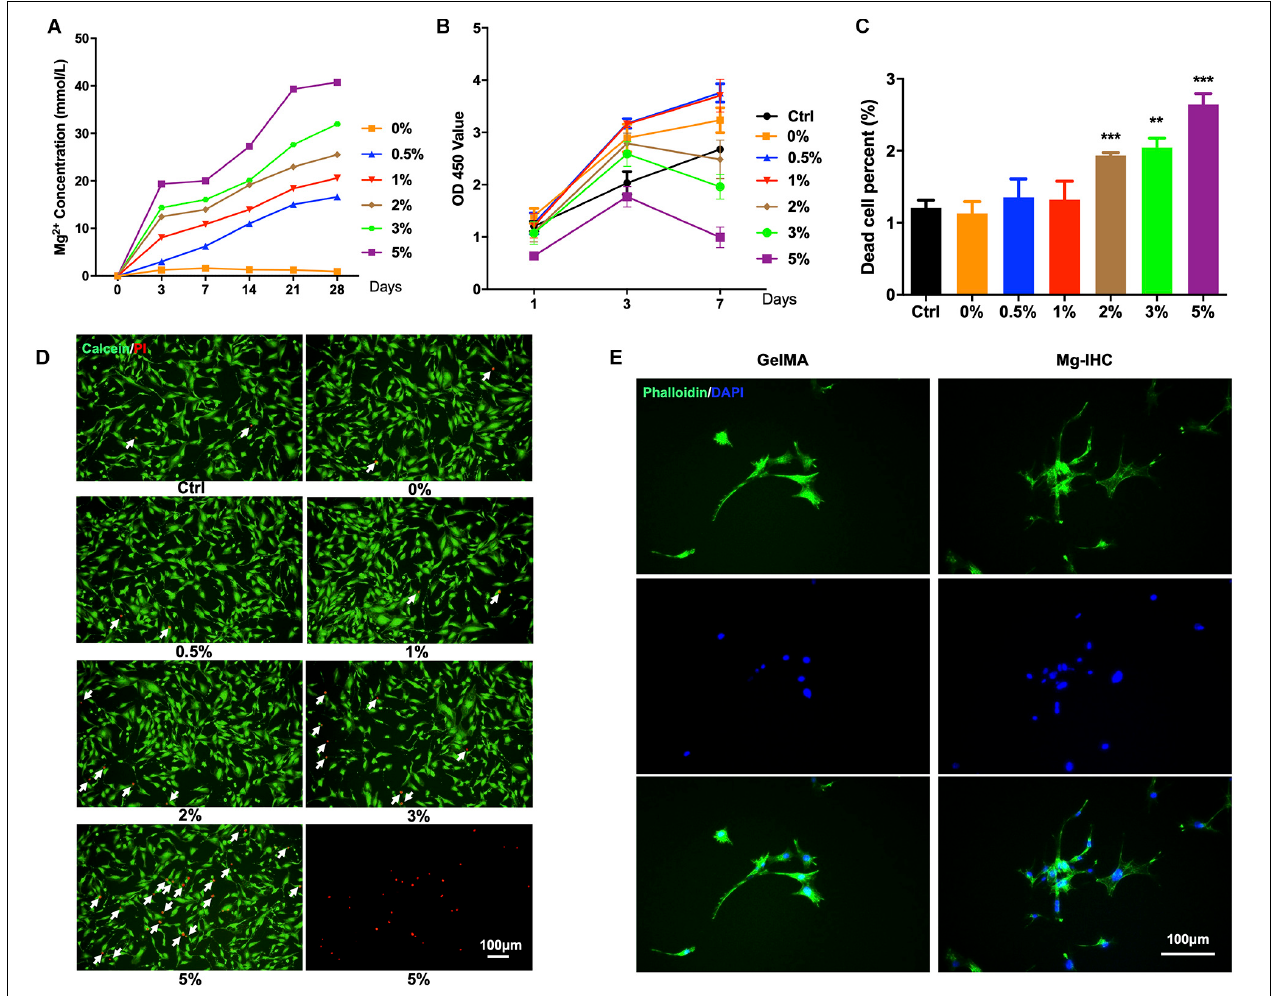
FIGURE 2 | In vitro biocompatibility test of Mg-IHC. (A) Magnesium ion concentration released by Mg-IHC in vitro was detected after 3, 7, 14, 21, and 28 days. (B) Cell viability detected by CCK-8 kit on 1, 3, and 7 days, respectively. (C) Statistics of the percentage of dead cells. Compare with Ctrl. ** P < 0.01; *** P < 0.001. (D) Live/dead staining for MC3T3-E1 cells. The white arrows indicate dead cells. (E) Cell actin cytoskeleton staining showing the morphology of MC3T3-E1 cells on different substrate, stained with